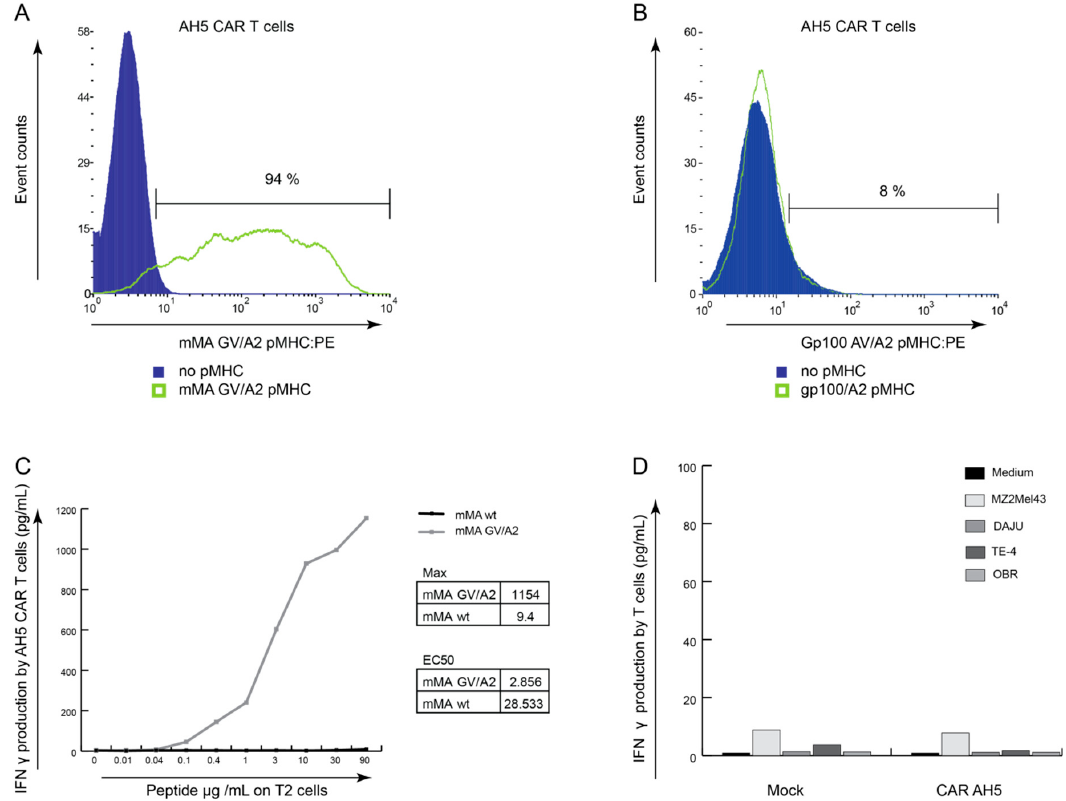
Figure 5. Anti mMA-GV/A2 antibody AH5, when expressed by T cells, recognises mMA-GV but not tumour cell-presented mMA-wt peptide. ( A ) AH5-CAR T cells bind specifically to mMA-GV/A2 complexes (green line). Filled (purple) histogram shows AH5-CAR T cells not stained with pMHC and were used as negative control. ( B ) AH5-CAR T cells do not bind irrelevant gp100/A2 complexes (green; filled (purple) histogram shows AH5-CAR T cells not stained with pMHC). ( C ) AH5-CAR T cells show increased IFN γ production when stimulated with T2 cells loaded with increasing concentrations of mMA-GV peptide. Non-loaded T2 cells yield no T cell IFN ɣ production. EC50 for mMA-GV is 2.9 ug/mL or 2.2 mM and for mMA-wt 28.5 ug/mL or 26.1 mM; calculated by GraphPad Prism and both maximum and EC50 values are displayed. ( D ) AH5-CAR T cells show no to negligible IFN γ production when stimulated with tumour cells expressing mMA-wt peptide. Medium served